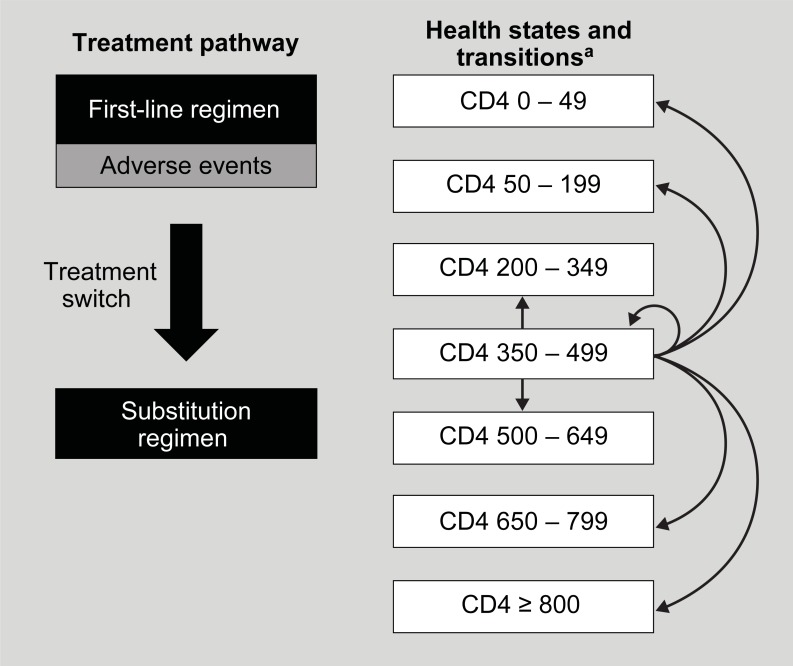
ACTG 5257 cost-analysis model overview.a As a simplification, transitions are shown for the 350–499 cells/μL CD4 cell count health state; similar transitions are allowed from the other health states.